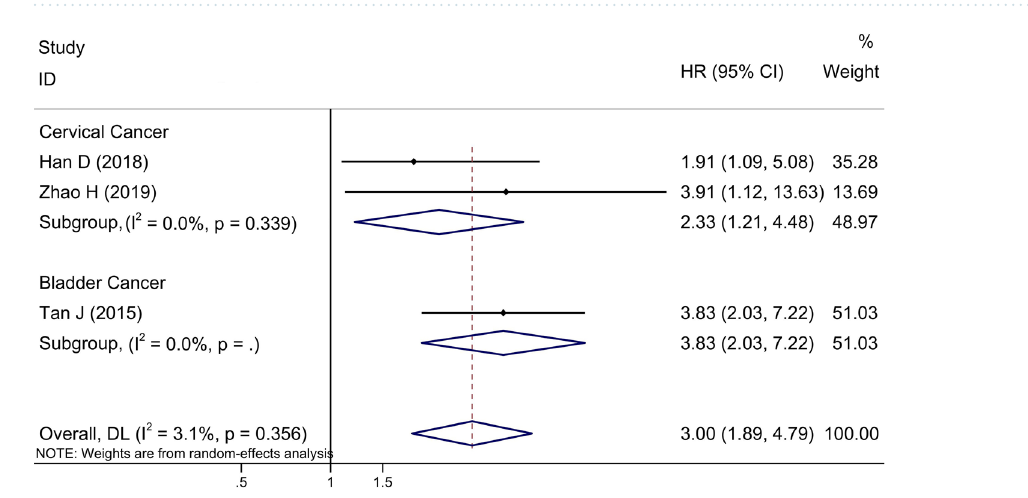
Figure 4. Forest plot for the association between lncRNA expression levels and OS according to tumor type, including cervical cancer and bladder cancer. OS overall survival, HR hazard ratio, CI confidence